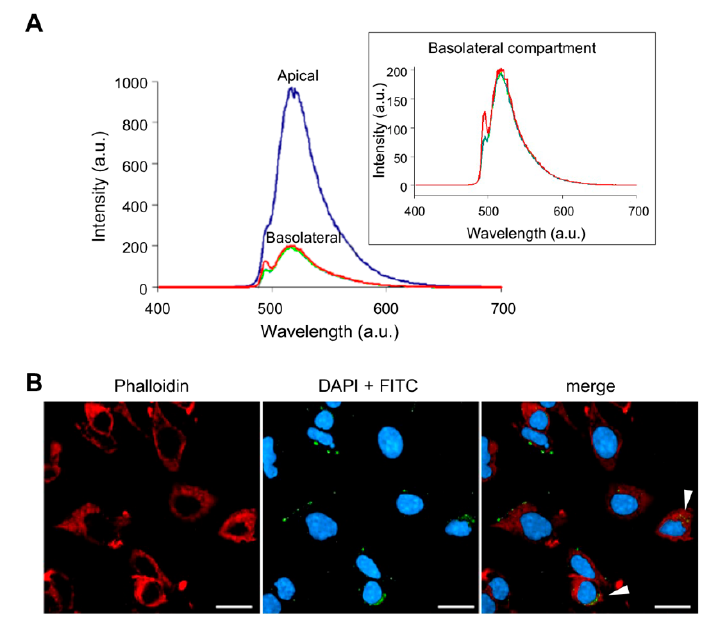
Figure 1. NHK1 peptide crosses biological membranes. ( A ) Analysis of NHK1 peptide permeability in the Transwell system through hCMEC/D3 cells. 30 µM NHK1-FITC was added in the apical compartment and the fluorescence in the basolateral compartment was determined. Colors represent the result obtained for each of three independent experiments. ( B ) Representative images of the NHK1-FITC peptide (in green) uptake by NSC34 cells. In red the Phalloidin Texas Red staining of actin. Arrows indicate the co-localization of signals. Bars represent 20 µm.